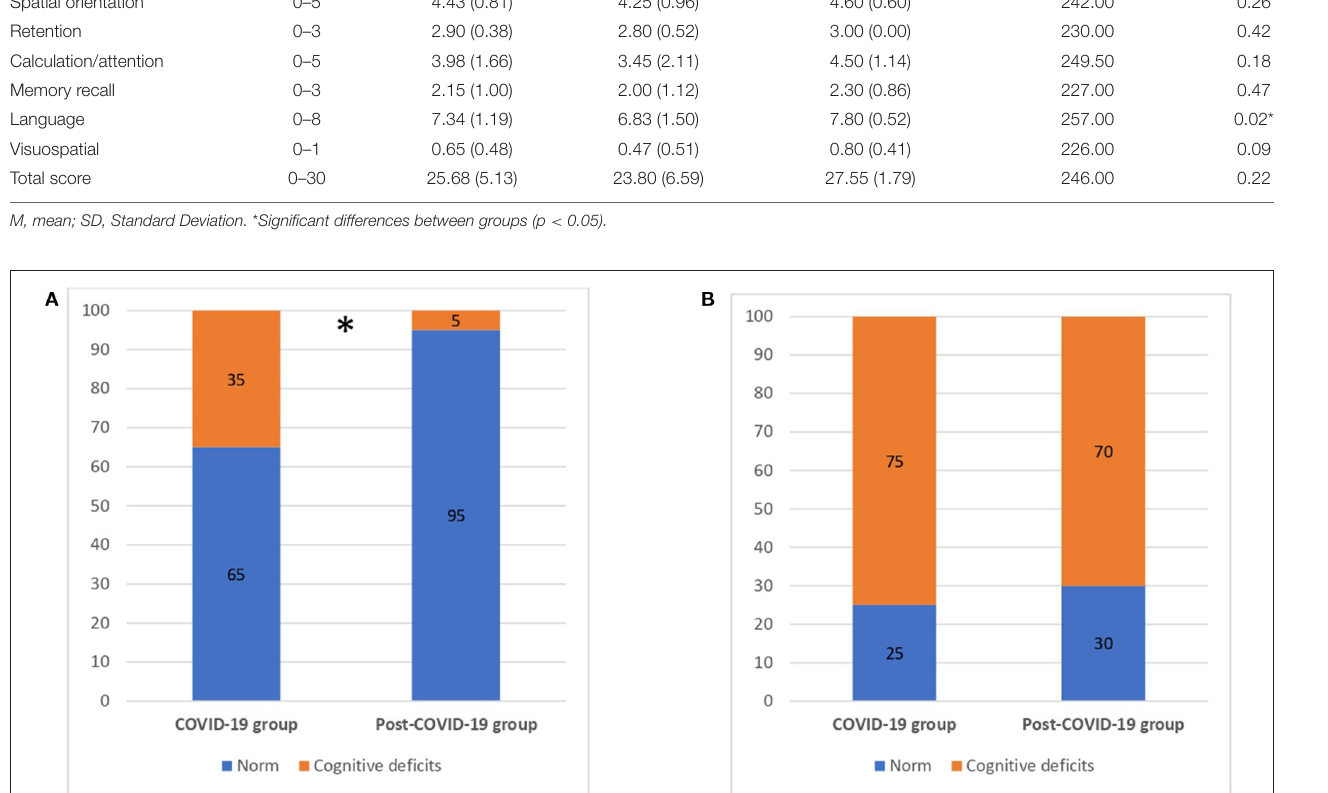
characteristics between COVID-19 and post–COVID-19